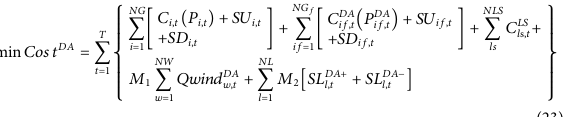
FIGURE 5 IEEE 30 bus